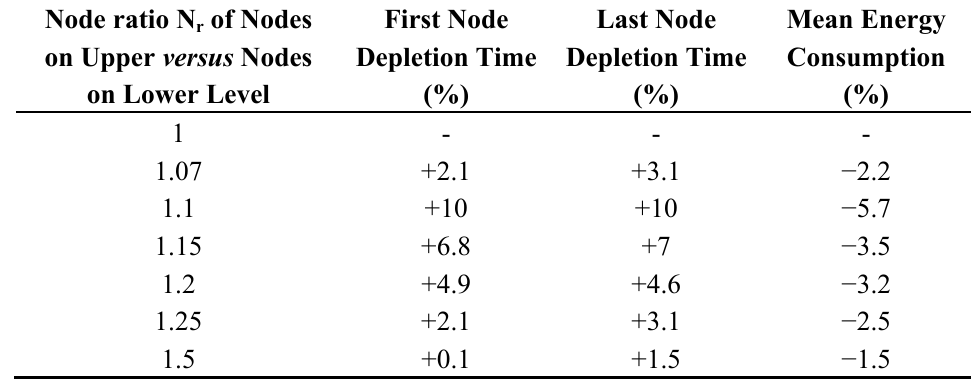
Table 3. Percentage of change in WSN performance by the use of ECHERP over the Node Ratio r when the base station is located 300m away from the center of the sensor